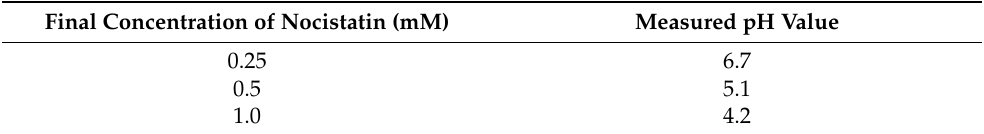
Table 1. pH values of solutions after dissolving nocistatin. Nocistatin was dissolved in a standard bath solution containing 10 mM HEPES. The pH was adjusted to 7.4 before dissolving nocistatin and the pH was then measured using a standard pH meter after dissolving different amounts of nocistatin. Final Concentration of Nocistatin